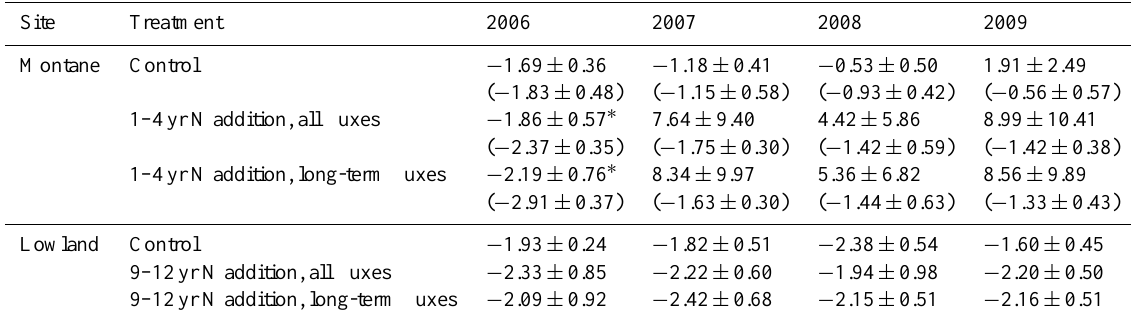
Table 1. Annual soil CH 4 -C fluxes (kgCha − 1 yr − 1 , mean ± SE, n = 4) from the control and N-addition plots, separated into all and long- term fluxes, with the latter including only the fluxes measured at least six weeks after a N application. For the montane forest, values in parentheses are estimates that excluded one pair of plots (control and N addition) which dominated CH 4 emissions (49 emission fluxes out of 351 plot-mean fluxes).